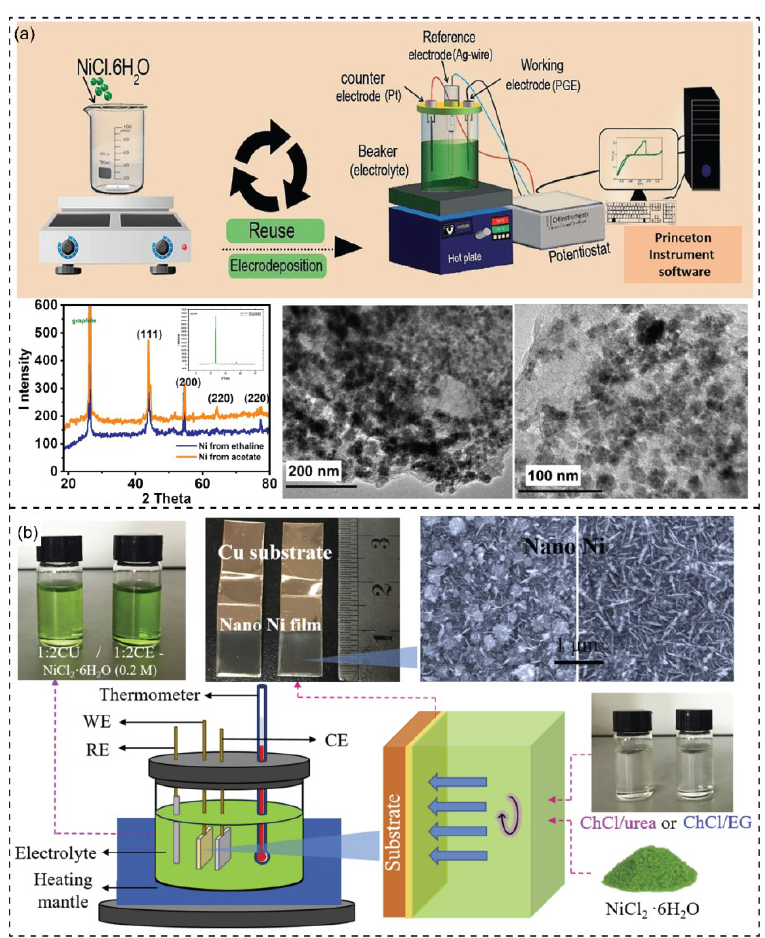
Figure 4. ( a ) Scheme of the electrodeposition of NiNPs in ethaline. XRD pattern of synthesized Ni/PGE in DES (ethaline) and in acetate bath. The inset graph displays the XRD pattern of PGE. TEM images show the deposited NiNPs from DES. Reprinted from ref. [134]. ( b ) Scheme of the DES-assisted electrodeposition of nanostructure Ni films on Cu substrate. The inset images show the electrolytes and SEM of as-fabricated nano-Ni films. Reprinted with permission from ref. [136]. Copyright 2018 Elsevier.